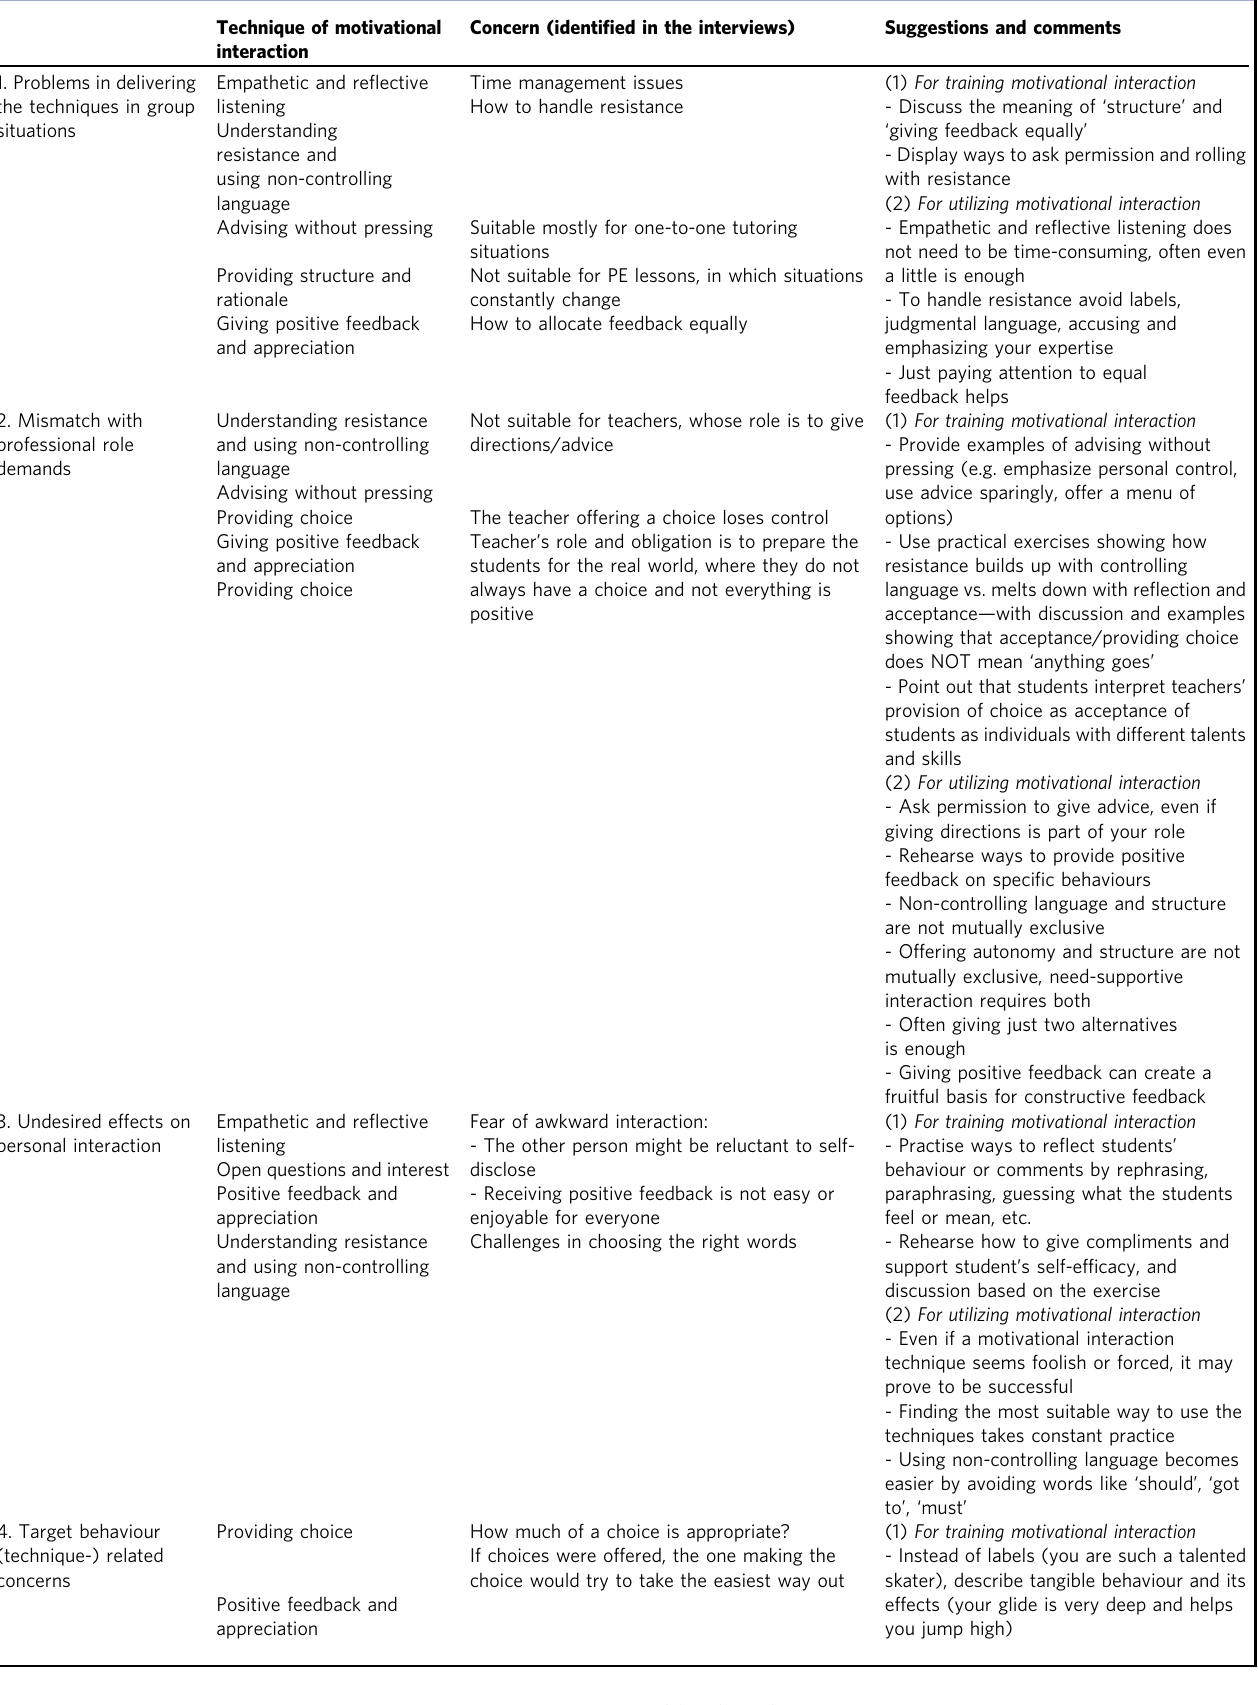
Table 3 Suggestions for responding to